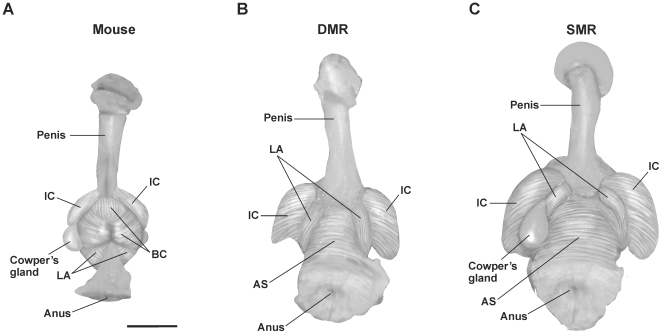
Illustrations of gross dissections of the penis and perineal muscles in a male mouse (A), Damaraland mole-rat (B), and silvery mole-rat (C).Dorsal is down. (A) In the mouse, the LA loops around the rectum and attaches to the base of the penis. Attachment sites of the LA are completely obscured by the bulbous BC, which encircles the ventral LA and also attaches to the penile bulb. A moderately sized IC is seen. (B) Damaraland mole-rats and (C) silvery mole-rats lack a prominent BC, leaving the ventral LA more exposed. Both Damaraland and silvery mole-rats possess large IC muscles and anal sphincters. Cowper's gland has been removed on the right side in (A) and (C). Cowper's gland was smaller and tucked under the LA in Damaraland mole-rats. Abbreviations: AS, anal sphincter; BC, bulbocavernosus; IC, ischiocavernosus; LA, levator ani. Scale bar = 500 µm.